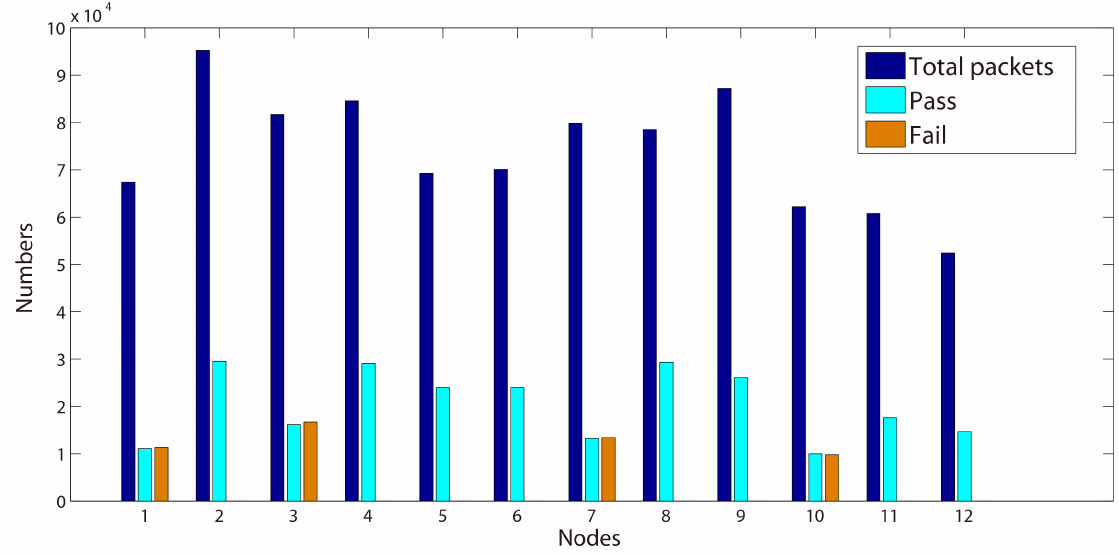
Figure 4. Test results for Property 3 (Day 1).